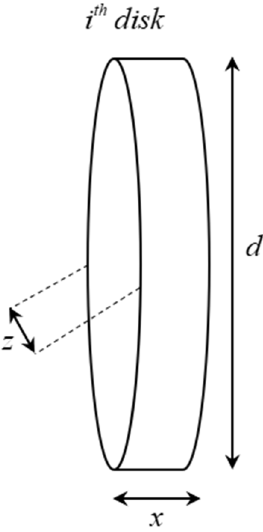
Figure 2. An example of a slice’s volume with two widths z and d , with z being the width observed from the top view and d being the width from the side view.